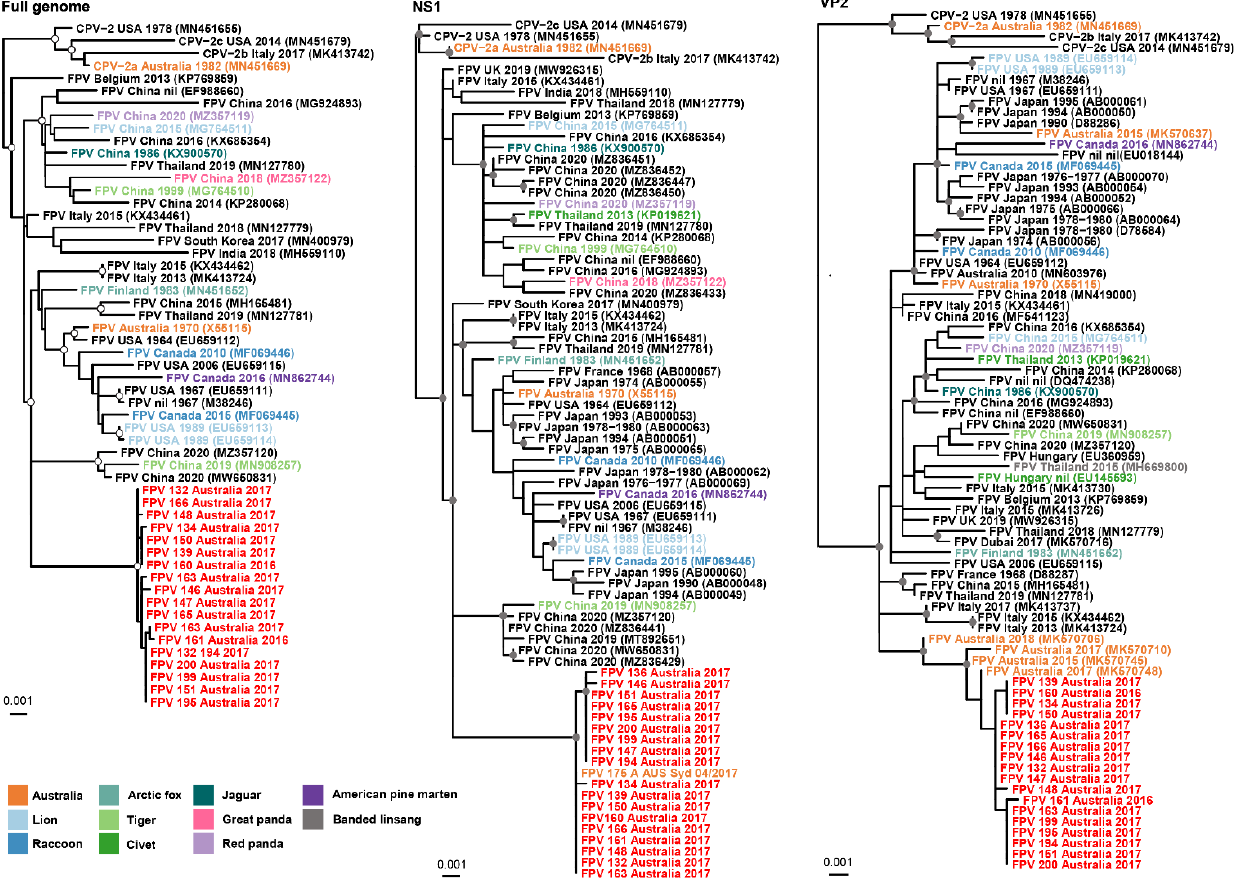
Figure 3. Phylogenetic relationships of the 18 FPV sequences described in this study and those retrieved from NCBI GenBank. All maximum likelihood trees are midpoint rooted for clarity, and sequences described in this study are highlighted in red and other Australian sequences in orange. Nodal support greater than 80% SH-aLRT and 95% UFBoot are represented by a grey circle. Sequences are designated in the phylogenetic trees by virus type (FPV or CPV), followed by the country year of isolation, and finally, accession number. The NS1 sequences for the Australian strains MK570748, MK570637, MK570710, and MK570706 are unavailable and therefore missing from both the full genome and NS1